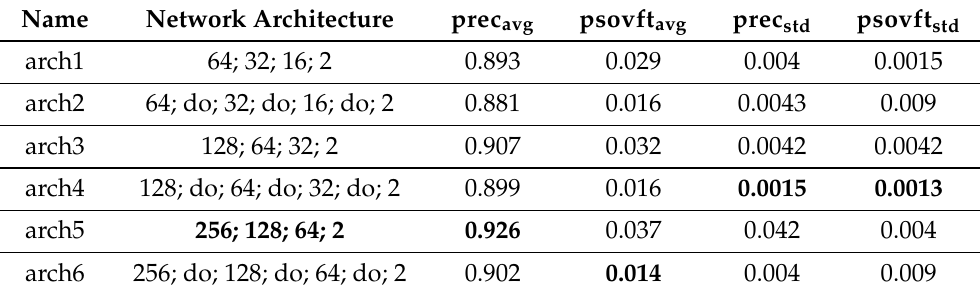
Table 3. Results of predicting the drowsiness labels using different neural network architectures.